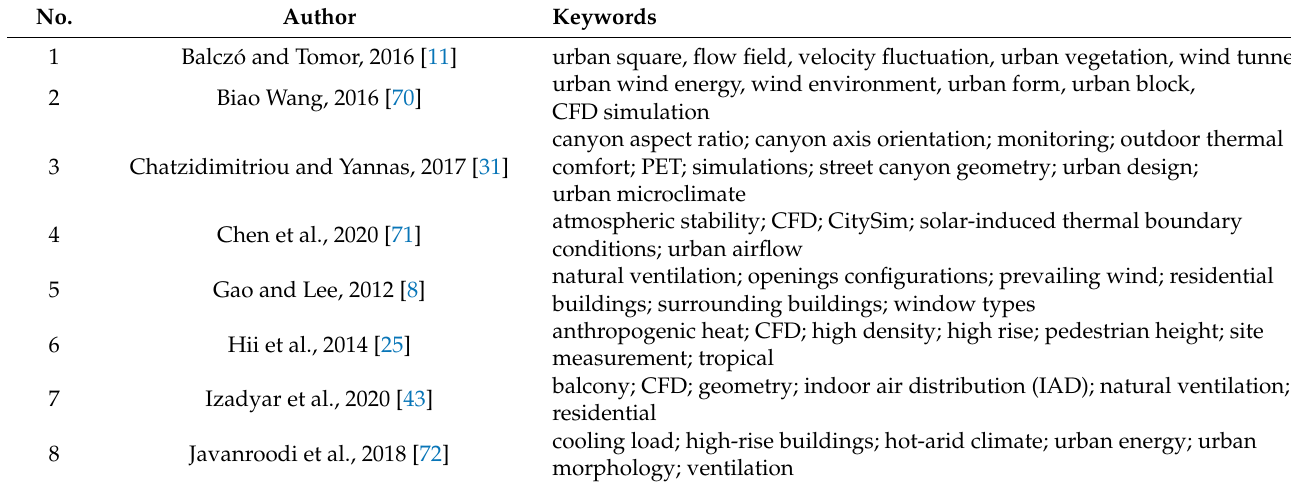
Table 7. Overview of studies of real urban areas with validation comparison with experimental or numerical data: listed